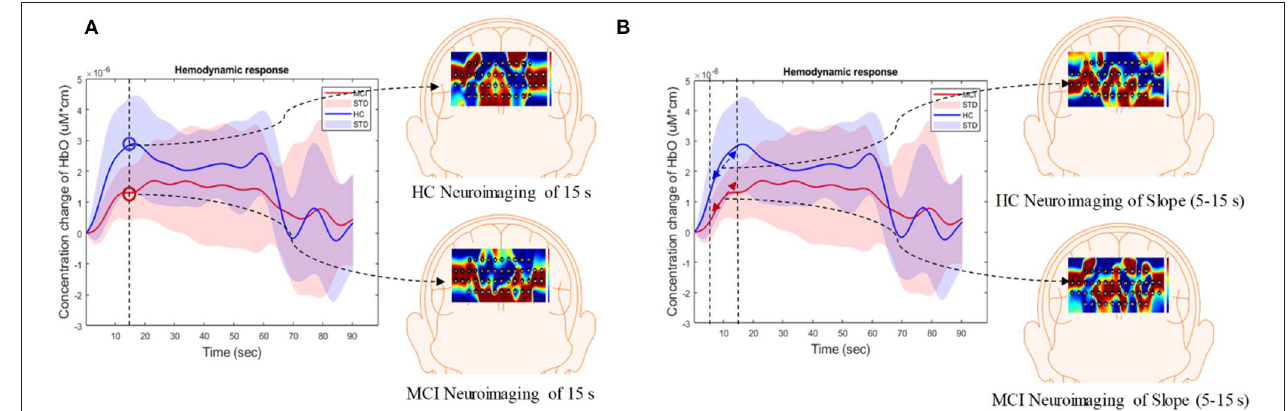
FIGURE 4 | Overview of (A) spatial features and (B) temporal-spatial features using the hemodynamic response of 1 HbO.